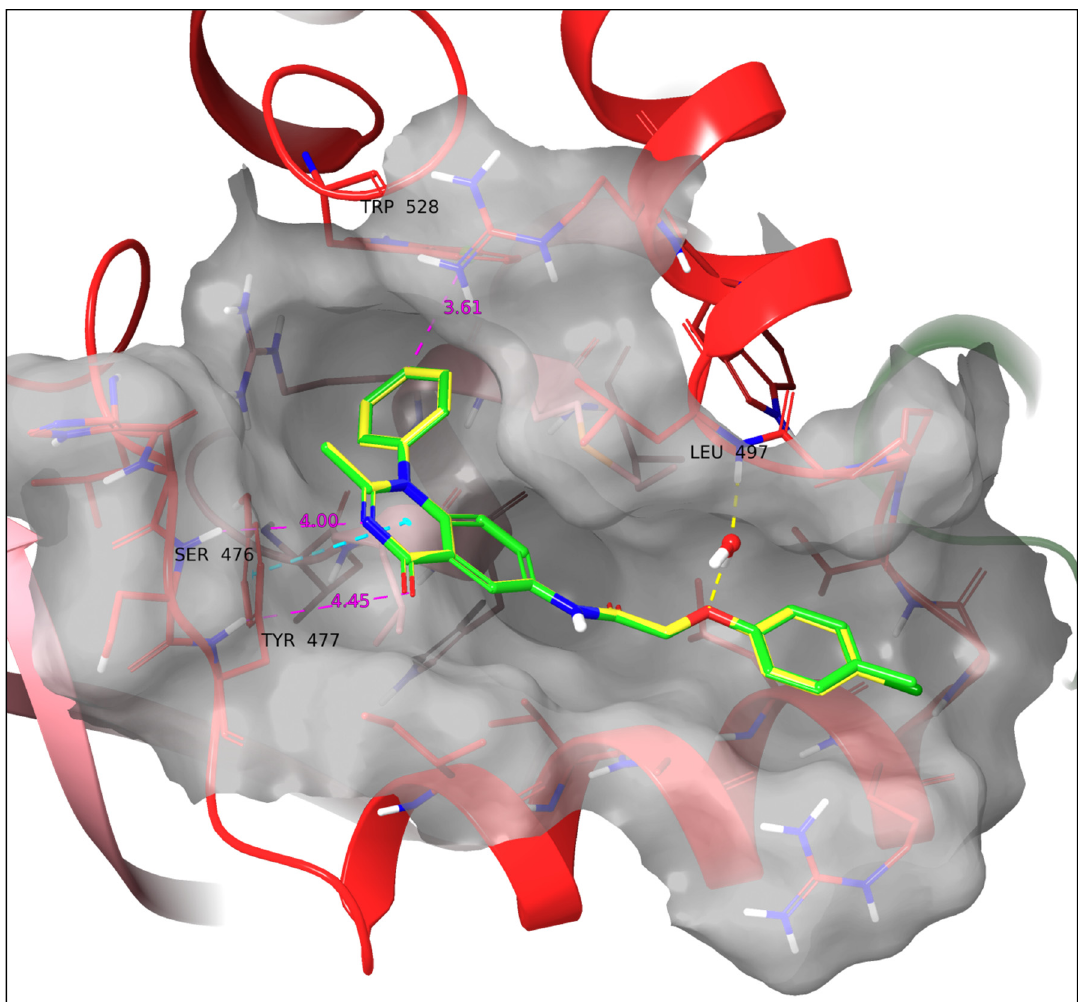
Figure 7. Docking poses of 11a (green) and 11b (yellow). The two ligands have an identical binding mode. A water bridge with Leu497 and a sandwich π – π stacking with Tyr477 are formed. Yellow dotted line: Hydrogen bond. Cyan dotted line: π – π interaction. All the above SARs were identified by employing the default settings of Maestro. Violet dotted line and number: Atom/ring distance in Å (measured